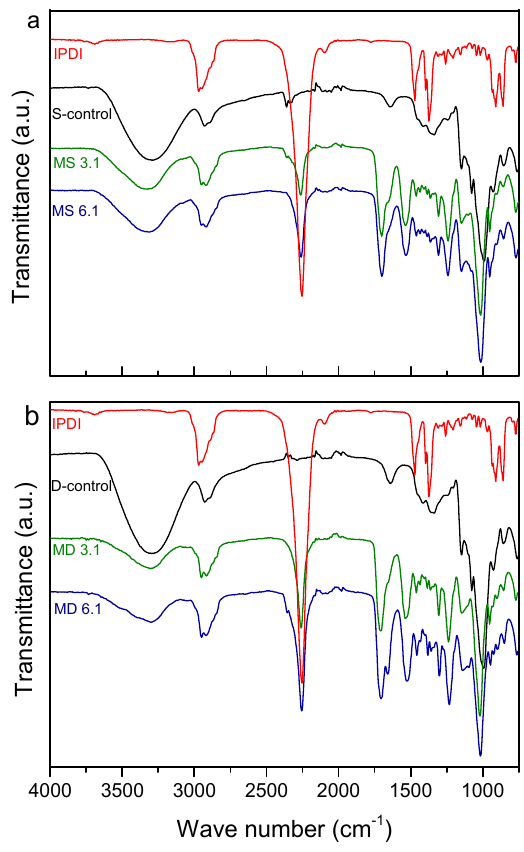
Figure 1. Fourier transform infrared spectroscopy (FTIR) spectra of IPDI, S-control, MS 3.1 and MS 6.1 ( a ), and IPDI, D-control, MD 3.1 and MD 6.1 ( b